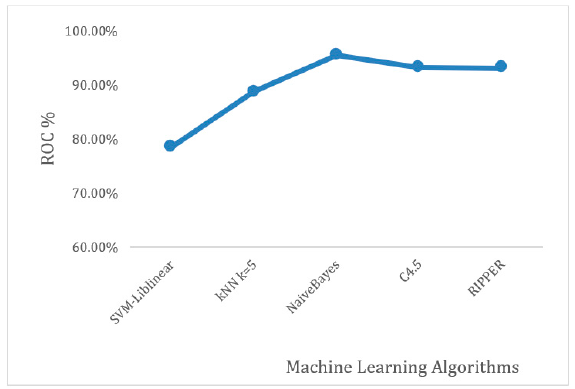
Figure 3. ROC area results.